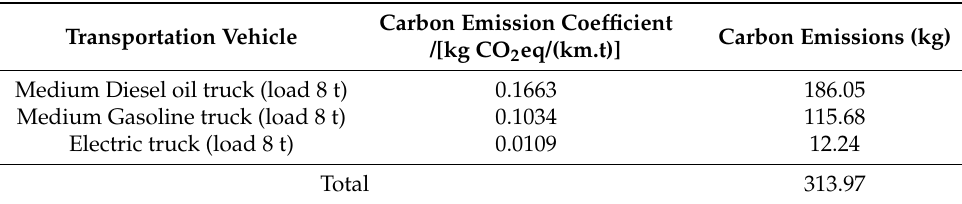
Table 6. Carbon emissions generated by three different energy consumption methods.